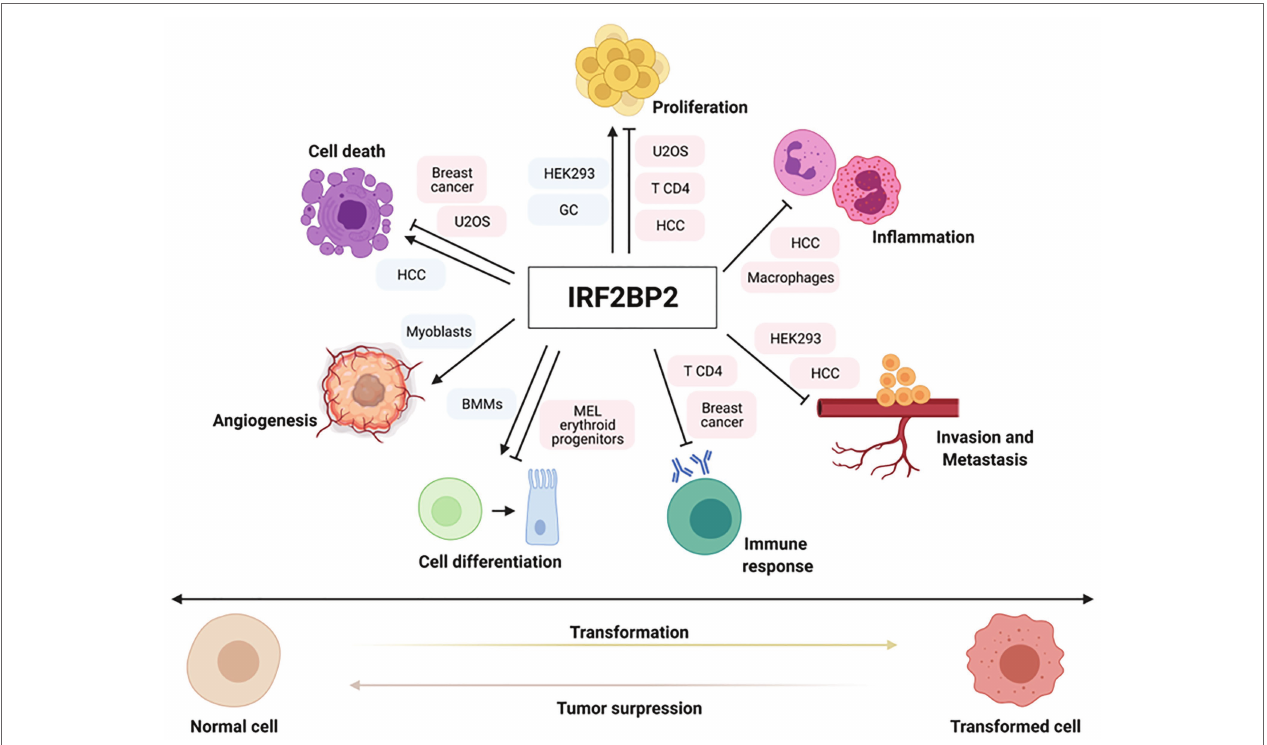
FIGURE 1 | Important pathways for tumor development are regulated by interferon regulatory factor 2-binding protein 2 (IRF2BP2). IRF2BP2 proteins are involved in regulating positive or negative expression of genes related to various hallmarks of oncogenesis, such as cell proliferation, apoptosis, cell differentiation, angiogenesis, immune response, inflammation and invasion/metastasis in normal and cancer setting. Boxes indicate normal and tumor cells where IRF2BP2 protein acts as a positive (blue) or negative (red) regulator of different cell